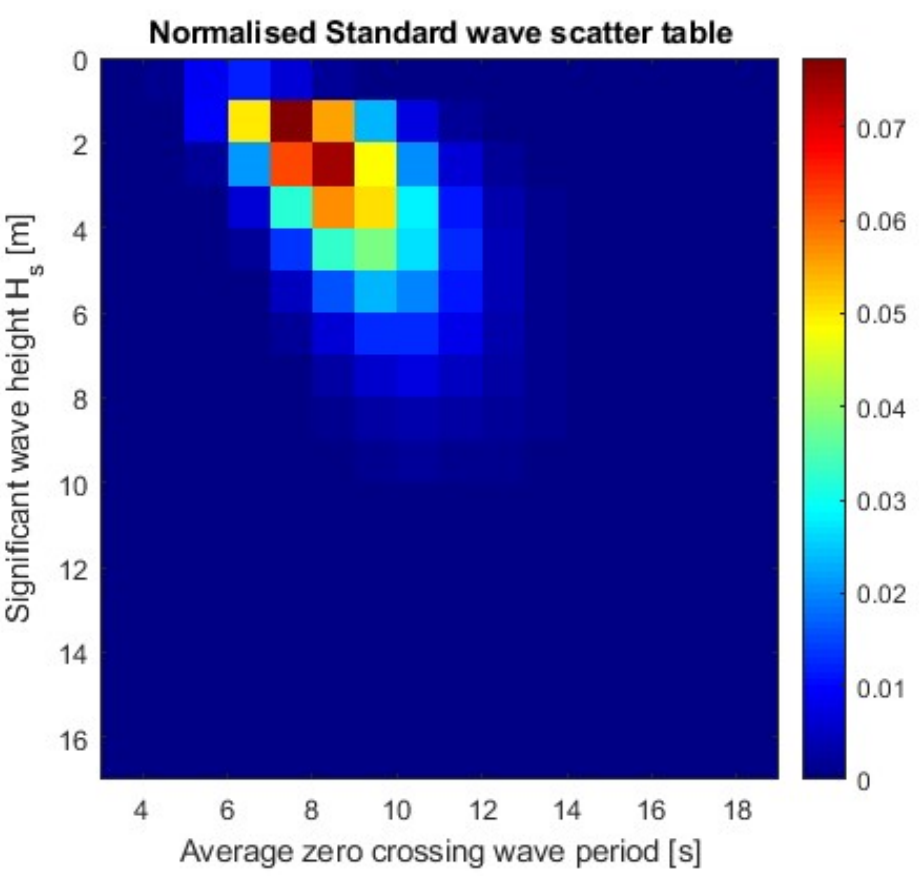
Figure 1. Existing standard WST (sea areas 8, 9, 15 and 16).